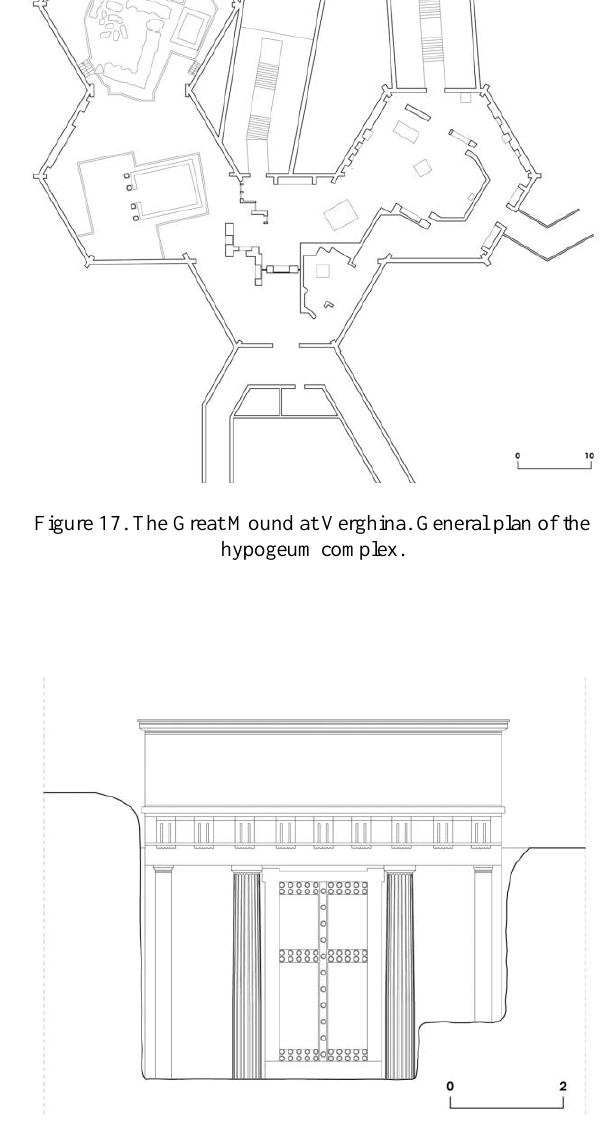
Figure 18. The Tomb of Philip II at Verghina.